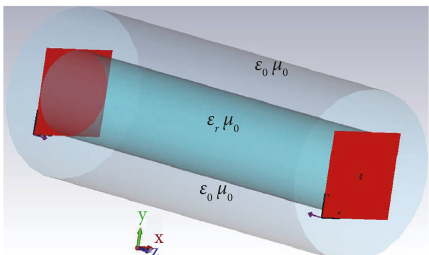
Figure 4: Perspective view of the circular dielectric rod surrounded with vacuum in CST.